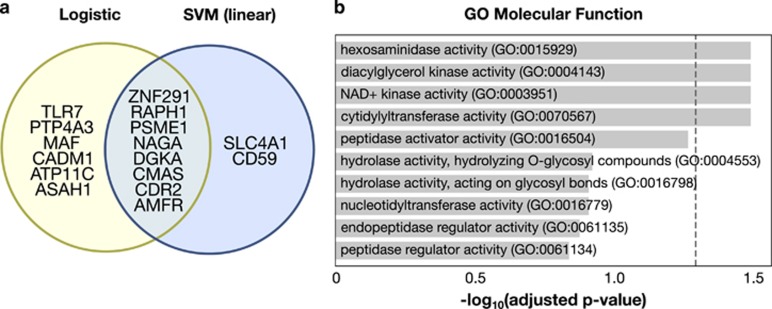
Some genes were highly predictive for diagnosing MDD, suggesting the biological processes underlying the etiology of major depression. Logistic regression and SVMs both identified genes with significant ability to predict MDD. (a) Maximum predictive power was achieved in logistic regression with 14 transcripts and in SVMs with 10 transcripts, with eight in common. These eight genes are hypothesized to have importance in explaining the biological processes underlying MDD. (b) Enrichr was used to find biological processes enriched in the eight common variables between logistic regression and SVMs. Four processes, as defined by the Gene Ontology (GO) database, were found to be significantly enriched (GO:0015929, GO:0004143, GO:0003951, and GO:0070567). The dotted line indicates the significance cutoff (adjusted p-value of 0.05). Together, these results suggest that multiple converging pathways may have independent roles in contributing to the depressive phenotype, and that MDD may have independent causal factors. MDD, major depressive disorder; SVM, support vector machine.